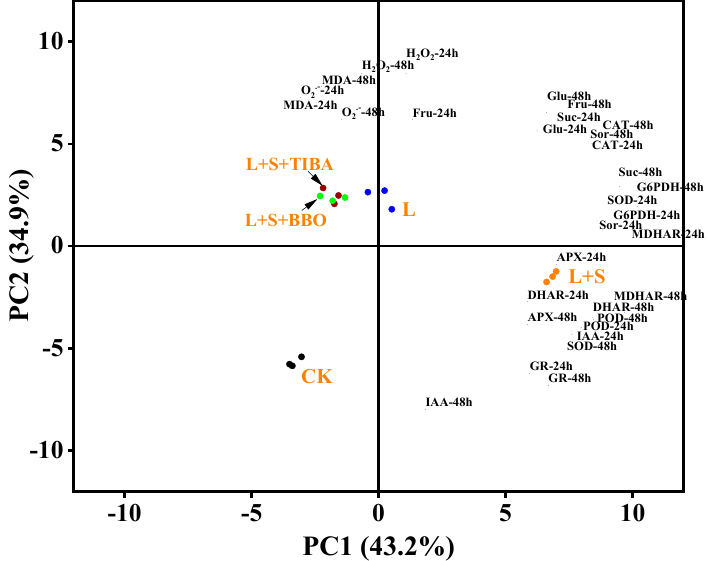
Figure 10. Principal component analysis of IAA levels, sugar contents, ROS contents, anti-oxidative enzymes, and antioxidants contents of M. baccata under sub-low temperature with exogenous su- crose and IAA inhibitors application. CK, control treatment; L, sub-low root-zone temperature (5 °C); L + S, 5 °C + 90 mmol·L − 1 sucrose; L + S + TIBA, 5 °C + 90 mmol·L − 1 sucrose + 500 μ mol·L − 1 2,3,5-triiodobenzoic acid; L + S + BBo, 5 °C + 90 mmol·L − 1 sucrose + 300 μ mol·L − 1 4-biphenylboronic acid.